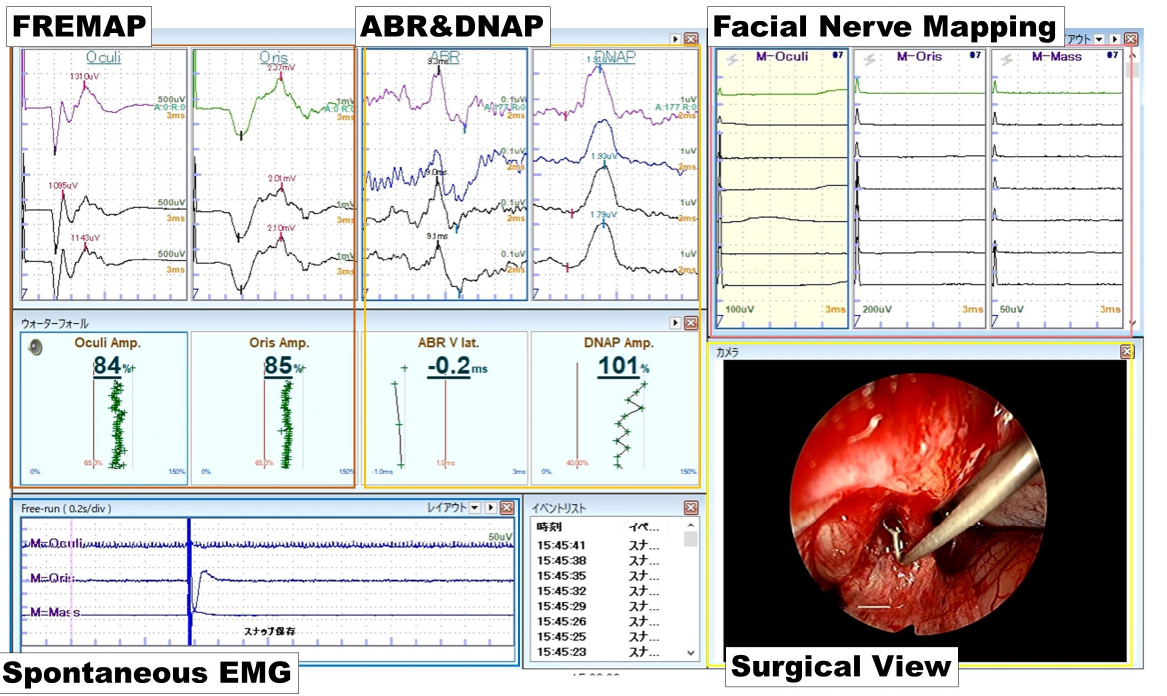
Figure 2. View of the intraoperative monitoring system. In this screen, the monitoring team can get information on surgical view, spontaneous EMG, FREMAP, ABR, and facial nerve mapping at a glance. In case of deterioration of the waveform is observed, the monitoring team would caution the surgeon. EMG: electromyography.